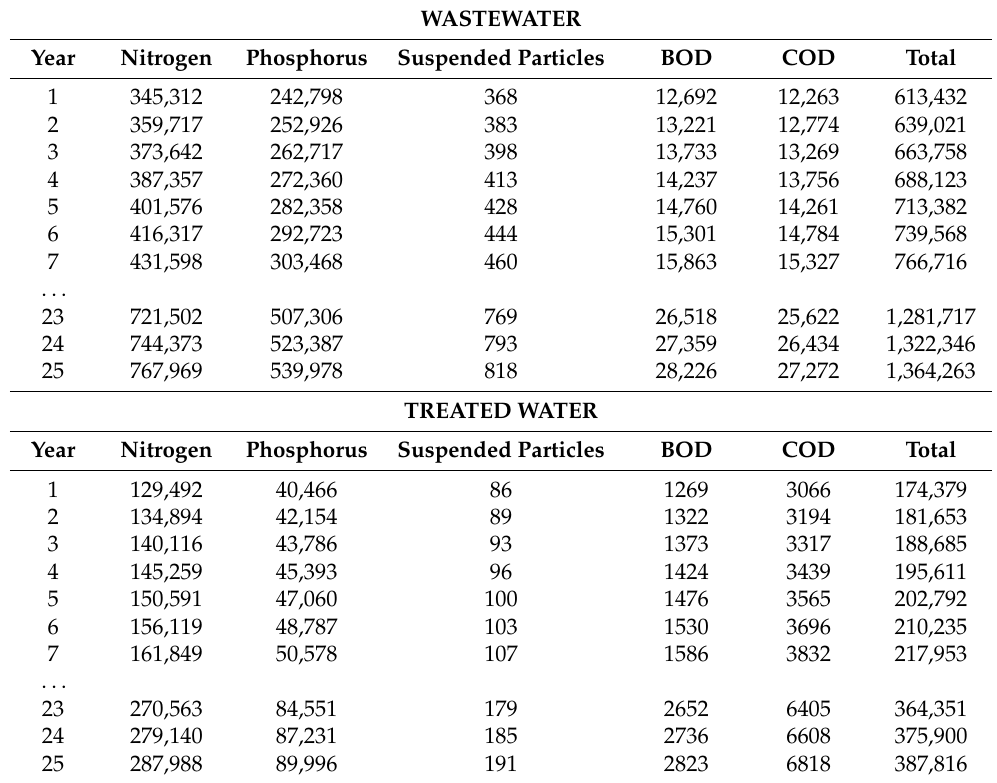
Table 12. Projection of pollution costs for wastewater and treated water (in